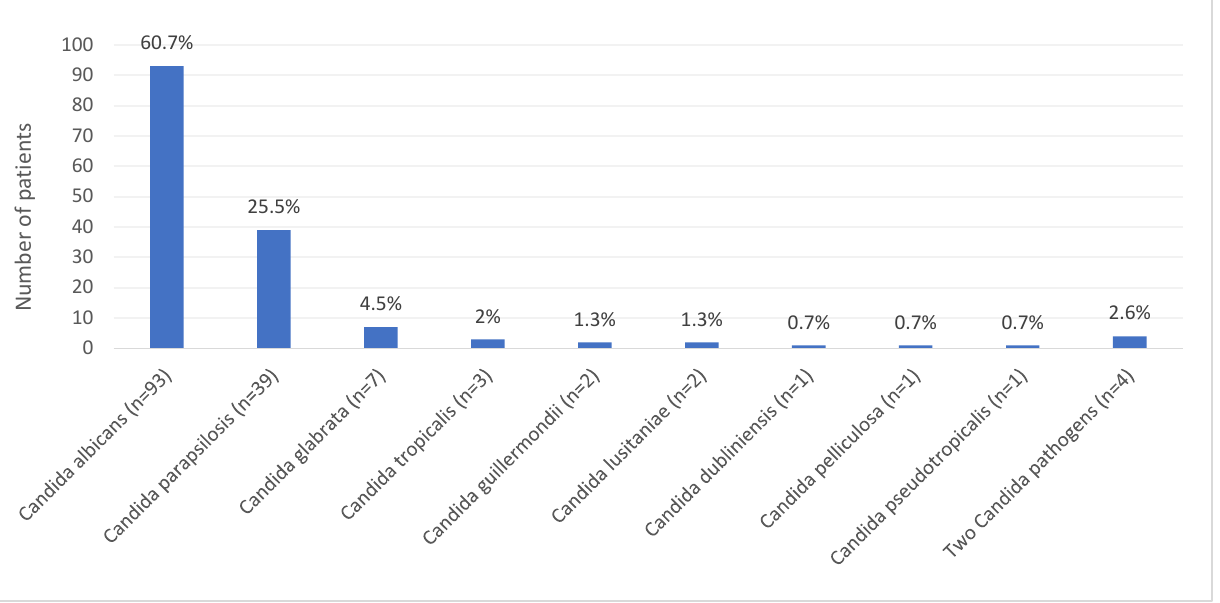
Figure 3. Patients with Candida PJIs among the 12 studies included in the review.